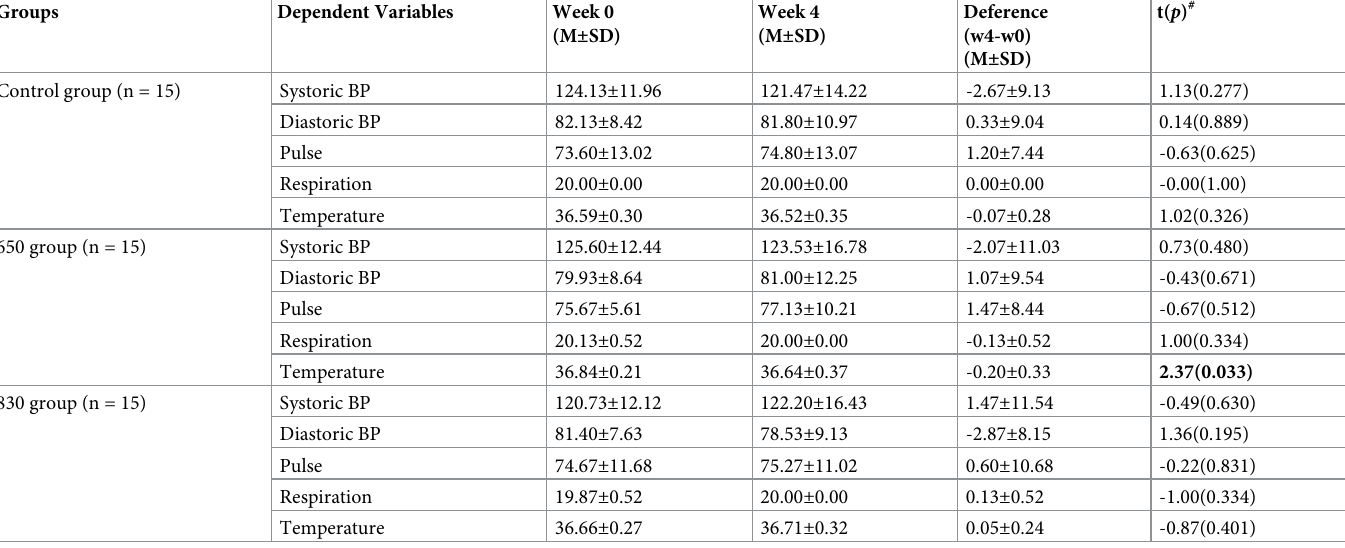
Table 6. Changes in vital signs (Week4 vs. Week0) after treatment completion within the three groups. Groups